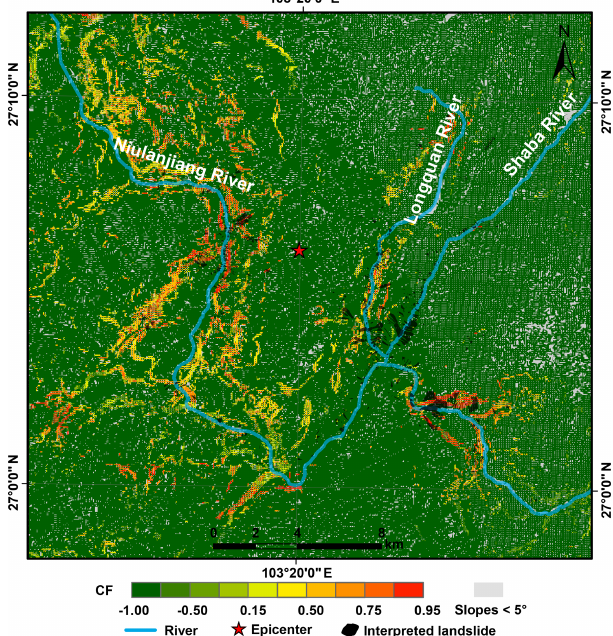
Figure 17. Map showing confidence levels of coseismic landslides during the Ludian earthquake using the proposed method. Confi- dence levels are portrayed in terms of values of